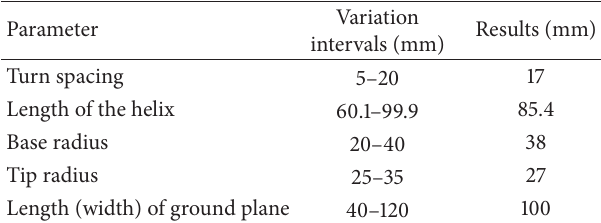
Table 2: Input parameters and results of the GA optimization pro- cedure for the helical antenna.